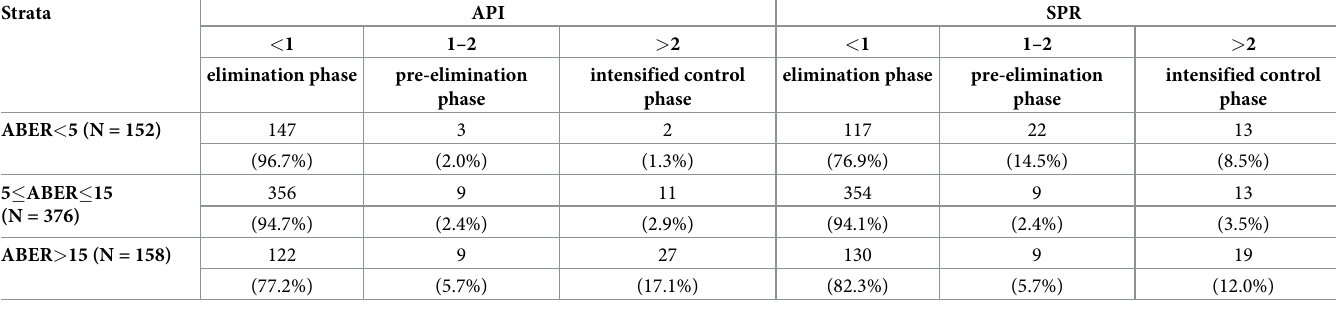
Table 2. Distribution of API and SPR as per National Strategic Plan (NSP 2017–22) in three strata of ABER.